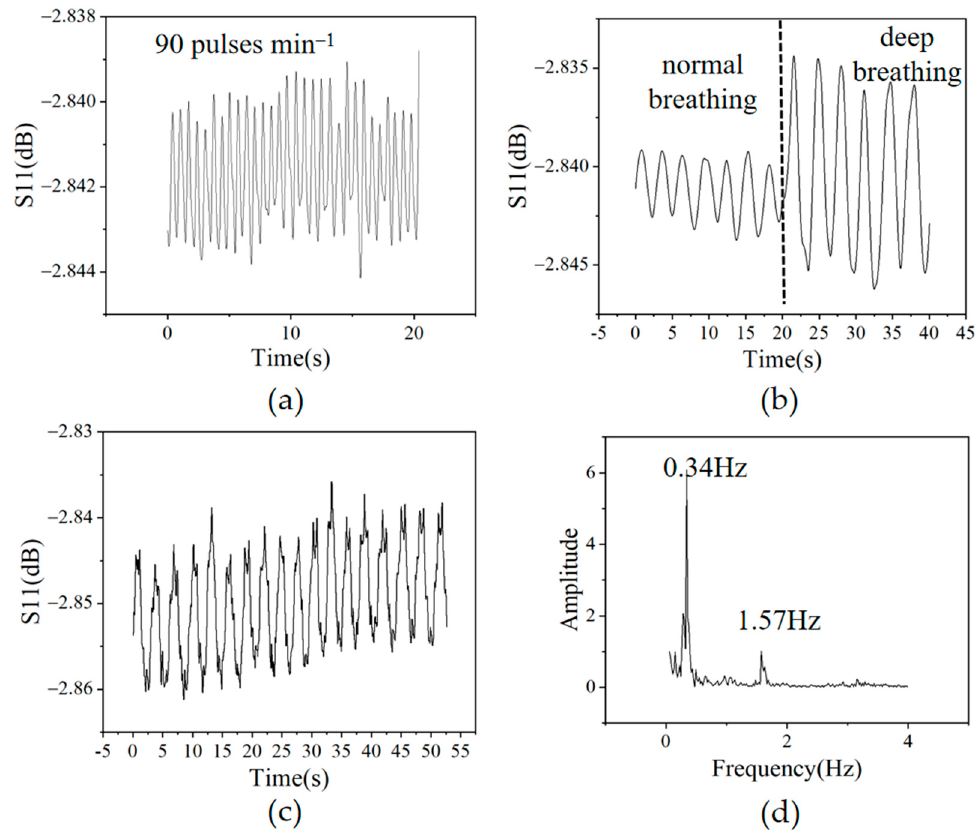
Figure 7. ( a ) Heartbeat monitoring result shows that the volunteer’s heart rate is 90 pulses min − 1 with ( b ) time-domain response of the sensor including both normal breathing and deep breathing; ( c ) time-domain fusion response of the sensor to heartbeat and breath; ( d ) frequency spectra of the fusion response showing a heartbeat frequency of 1.57 Hz and respiration frequency of 0.34 Hz.